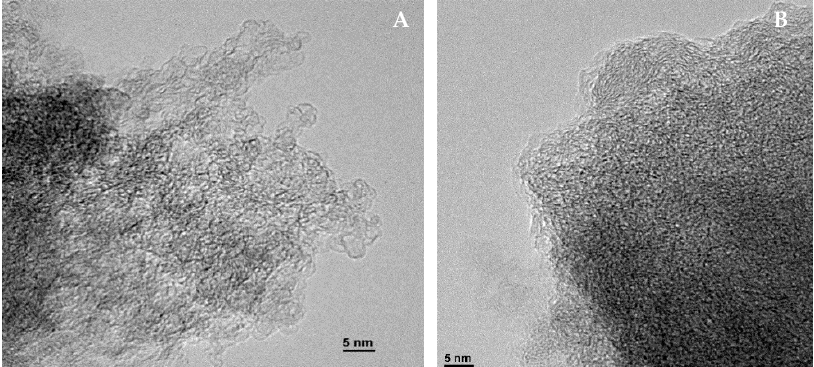
Figure 3. TEM images of activated carbons: ( A ) PAC; ( B ) GAC.